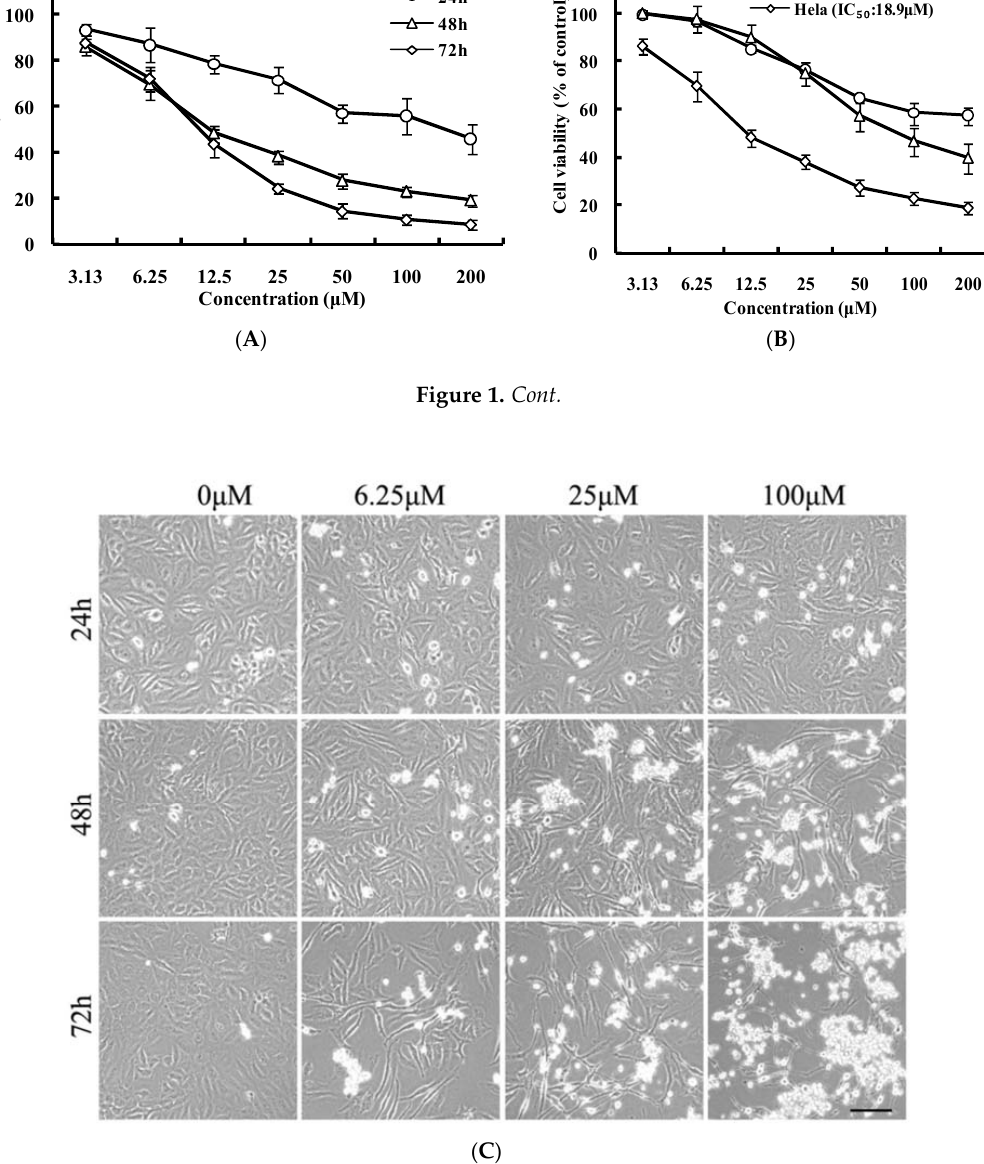
Figure 1. Effects of luteoloside on cell proliferation and cell morphology. Cells ( A : Hela. B : HUVEC12, LO2, and Hela) were treated with luteoloside at 3.13, 6.25, 12.5, 25, 50, 100, and 200 μ M for 24 ( A ), 48 ( A , B ) and 72 h ( A ). Cell growth was determined using cell counting kit-8. Data are the mean ± SD of three independent experiments. ( C ) Hela cells were treated with luteoloside at 0, 6.25, 25, and 100 μ M for 24, 48, and 72 h and photographed. Bar = 25 μ m.